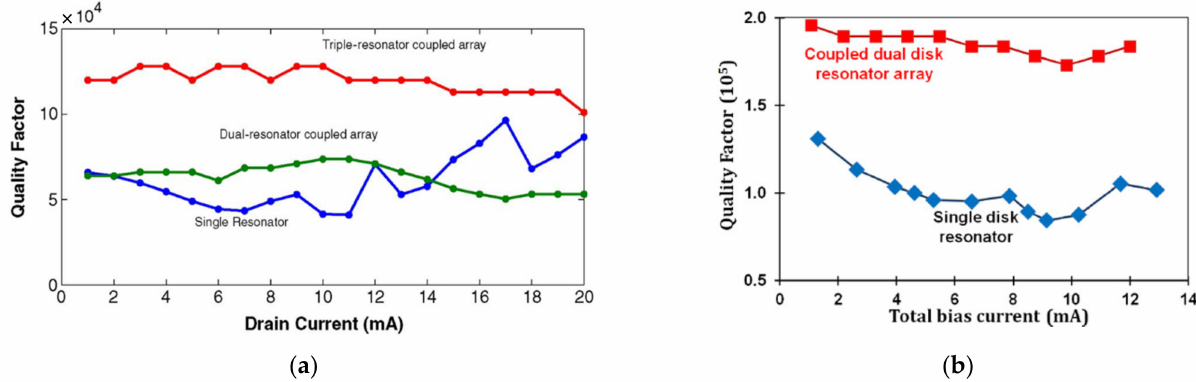
Figure 29. ( a ) Comparison of Q factors among the single, 2-DoF and 3-DoF square-plate BAW resonators as the drain current (Reprinted with permission from Ref. [37]); ( b ) Comparison of Q factors between the single and 2-DoF disk BAW resonators with bias current increasing (Reprinted with permission from Ref.